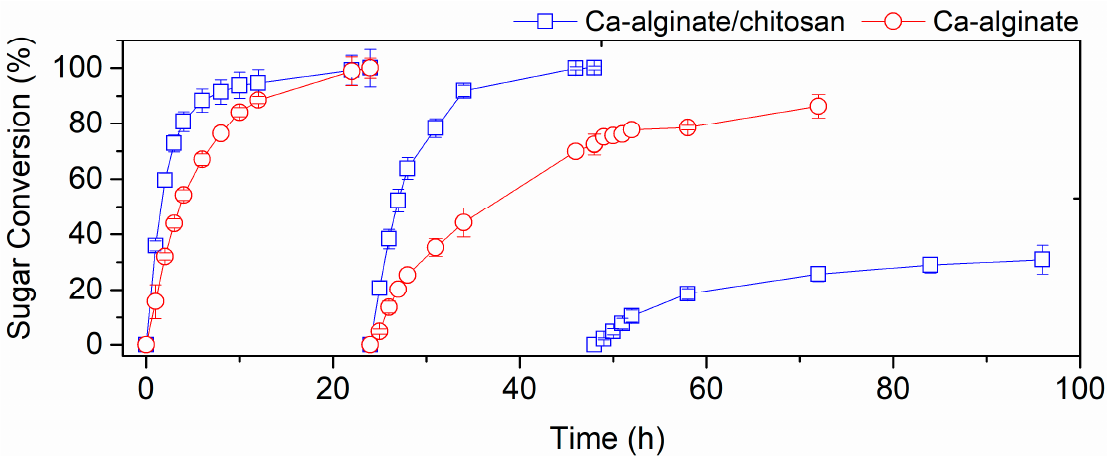
Figure 3. Recycling for sugarcane bagasse hemicellulose hydrolysate supplemented with urea (2 g/L) using T18 yeast immobilized in Ca-alginate (red circles) and in Ca-alginate/chitosan hybrid gel (blue squares). Experiments performed with 1:1 V beads /V medium , 35 ◦ C, 150 rpm, and pH 5.2. Table 2. Performance indexes for encapsulated T18 yeast recycles in sugarcane bagasse hemicellulose hydrolysate supplemented with urea (2 g/L) (35 ◦ C, 150 rpm, and pH 5.2). (a–q) Matching letters indicate that the means did not differ significantly, according to the Tukey test at 95% confidence.